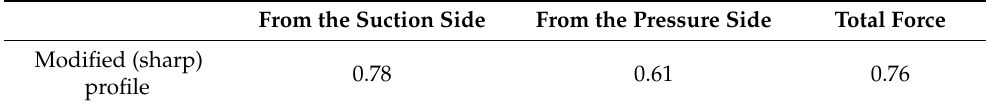
(cid:0) (cid:1) (cid:0) (cid:1) F x F x / . ice ice sharp blunt